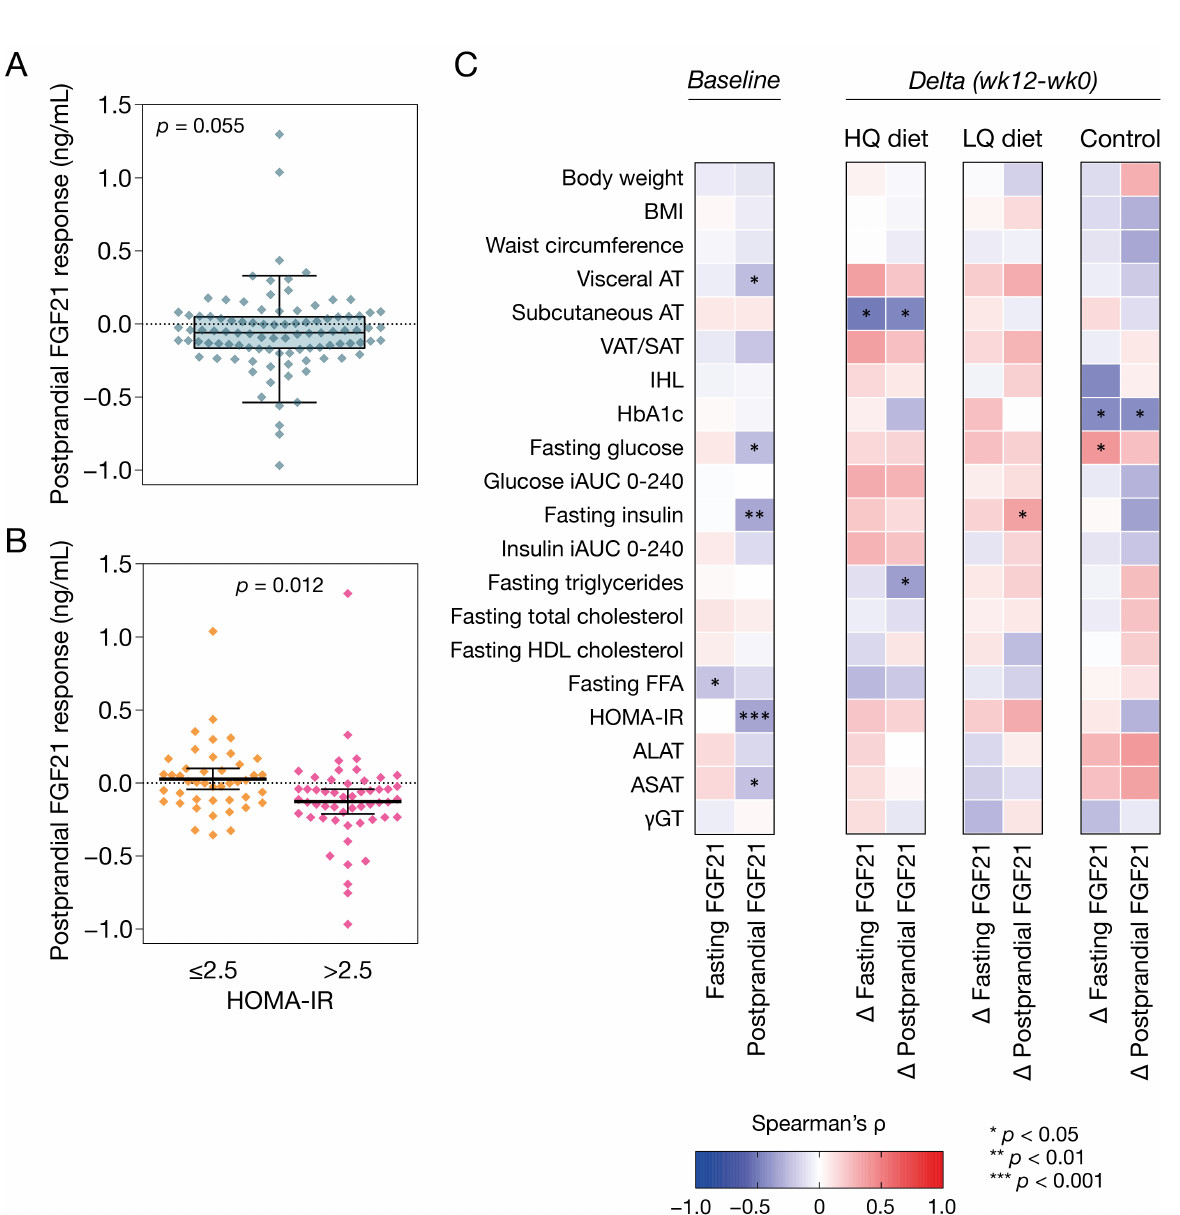
Figure 2. Postprandial FGF21 response at baseline and correlations between plasma FGF21 and markers of metabolic health. ( A ) Box plot with individual data points of the change in plasma FGF21 levels from the fasting state to 120 min after the consumption of the mixed meal in the complete population at baseline ( p = 0.055, as tested using a paired-samples T-test). The box plot represents the 5th percentile, first quartile, median, third quartile, and 95th percentile. ( B ) Individual postprandial FGF21 responses according to baseline HOMA-IR: ≤ 2.5 or >2.5 ( p = 0.012 for the difference between groups, as tested with ANCOVA, adjusted for fasting FGF21, age, gender, and BMI. ( C ) Spearman correlations between fasting FGF21 and the postprandial FGF21 response with cardiometabolic parameters at baseline (left) and in response to a 12-week intervention (right). Abbreviations: BMI, body mass index; AT, adipose tissue; IHL, intra-hepatic lipid content; HbA1c, glycated hemoglobin A1c; iAUC, incremental area under the curve; HDL, high-density lipoprotein; HOMA-IR, homeostatic model assessment of insulin resistance; ALAT, aminotransferase; ASAT, aspartate aminotransferase; γ GT, gamma-glutamyl